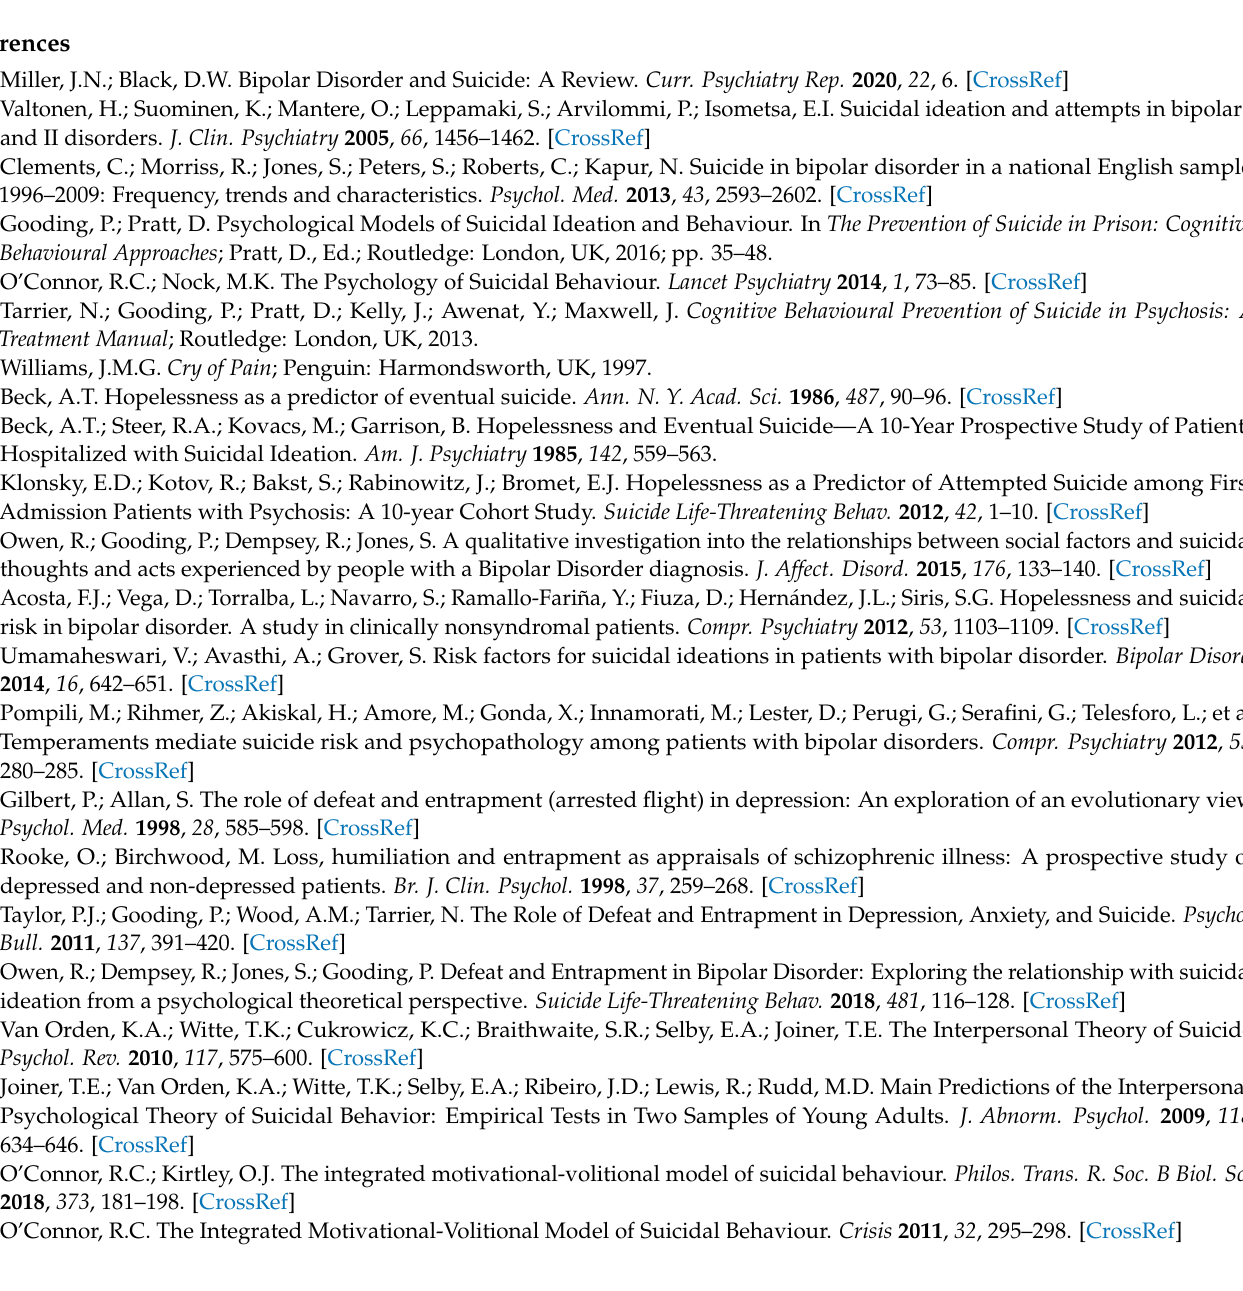
Resource Questionnaire. The italicized values indicate that the Pearson’s product–moment correlation coefficient for parametric data was used, whereas the non-italicized values indicate that Spearman’s correlation coefficient was